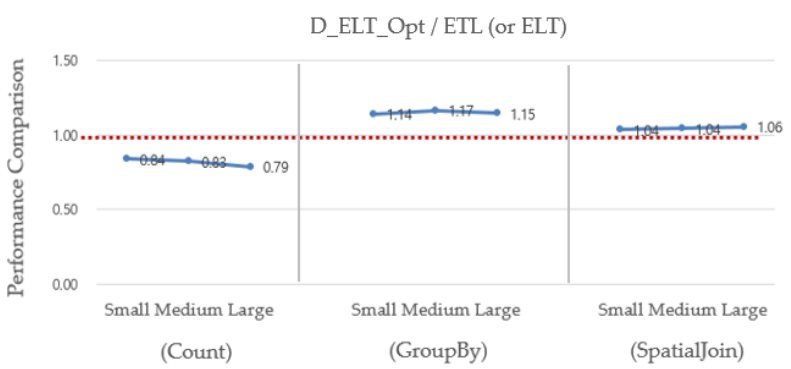
Figure 10. Performance comparison of optimized D_ELT / ETL(or ELT) based on the small, medium, and large data size for each of three analyses: Count, Group-By, and SpatialJoin.